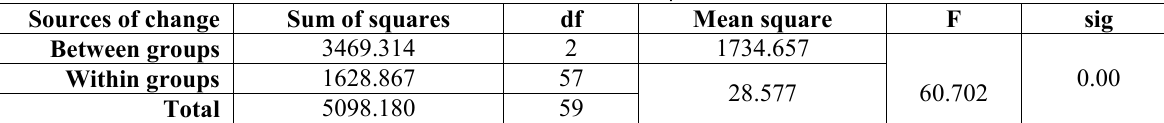
Table 2. The results ANOVA test for comparison of the mean VO2max